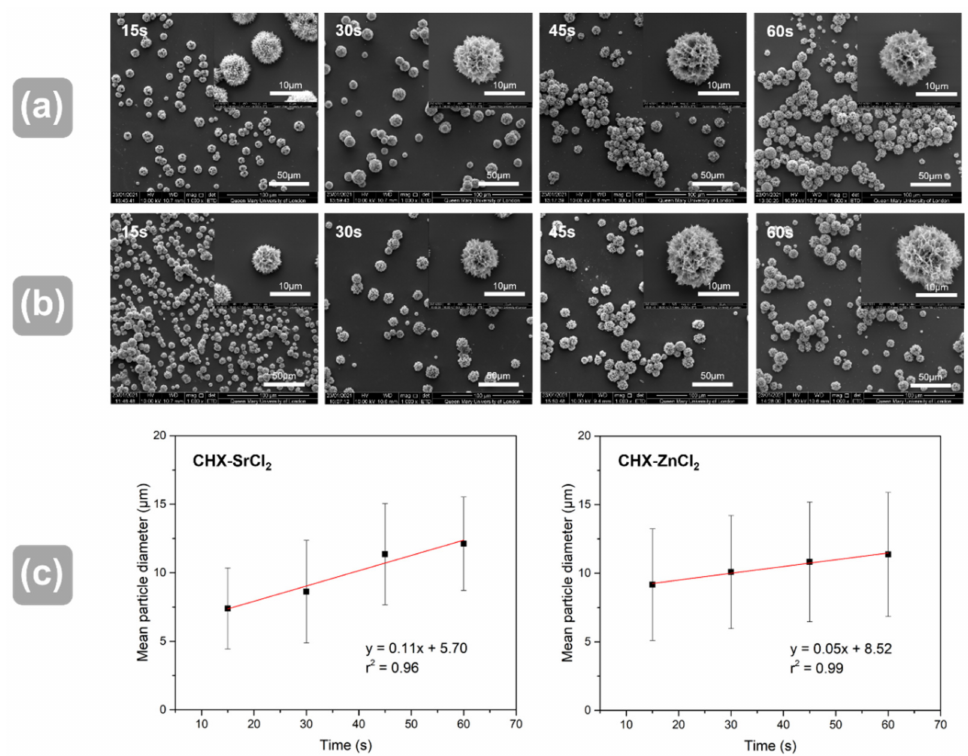
Figure 5. SEM images of ( a ) CHX-ZnCl 2 particles; ( b ) CHX-SrCl 2 particles at different reaction times; and ( c ) plots showing the correlation between the mean particle diameter and reaction time for both CHX-SrCl 2 and CHX-ZnCl 2 particles.